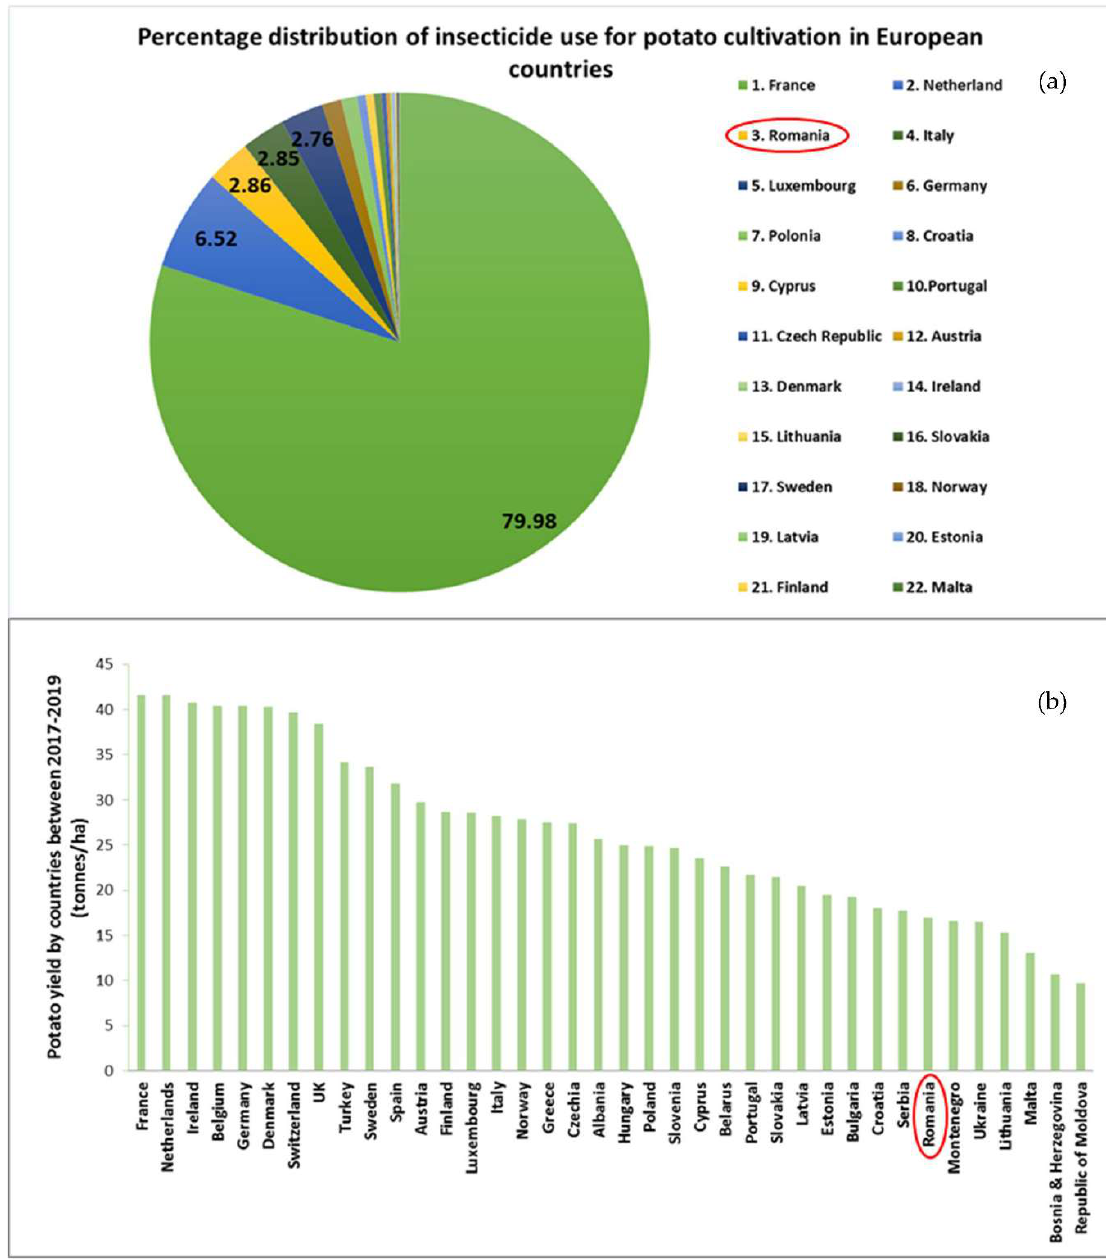
Figure 7. a. Percentage distribution of insecticide use for potato cultivation in European countries (statistics for the last 10 years) b. Potato yield by countries between 2017 and 2019 (tonnes/ha) (the presented graphics are based on data obtained from FAOSTAT database [102]).